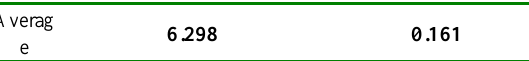
Tab. 5 Heights’ Differences on TPs with Different Algorithms